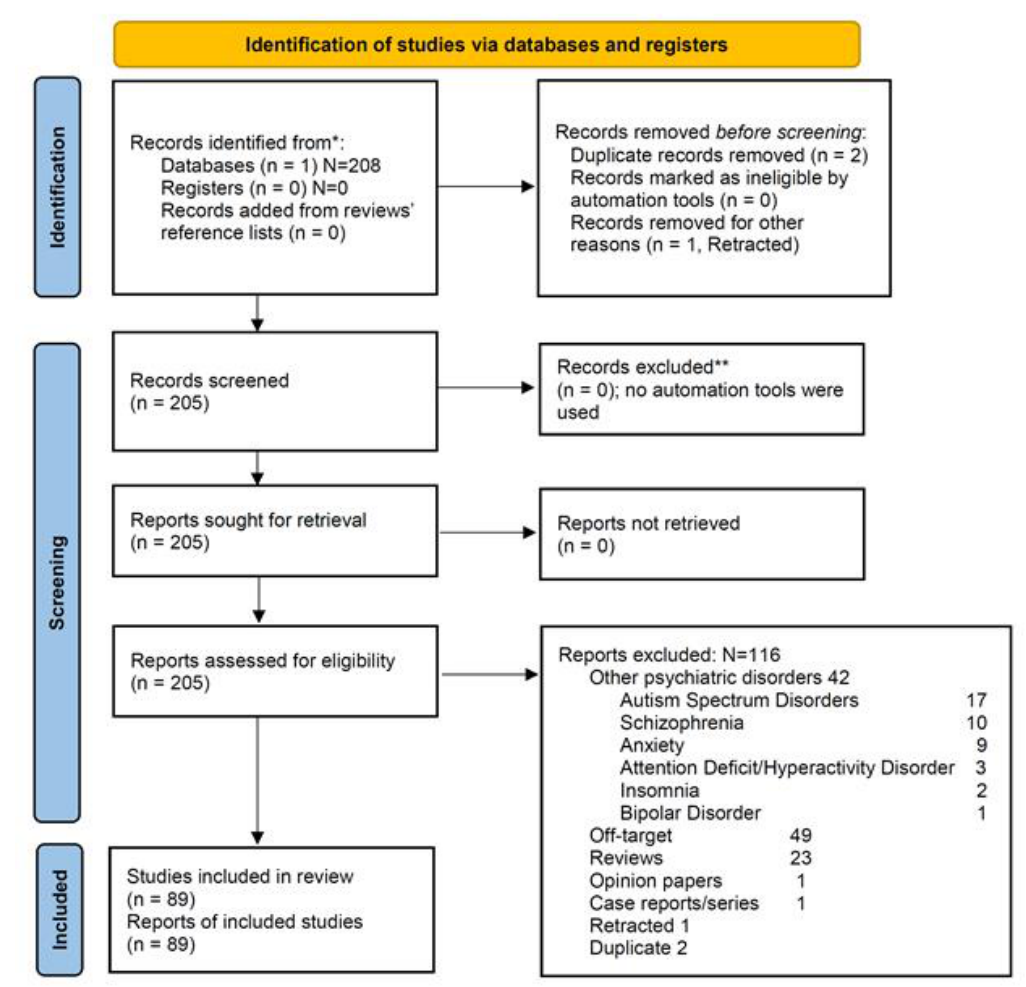
Figure 1. PRISMA 2020 flow diagramme (From [31]: Page, M.J.; McKenzie, J.E.; Bossuyt, P.M.;